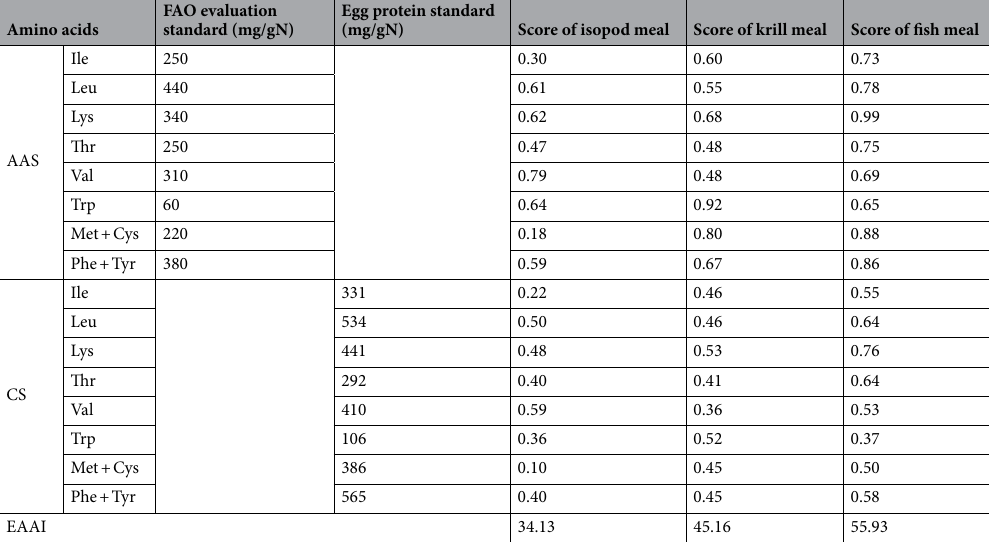
amino acid index) and essential amino acid index (EAAI) were calculated by converting the data in Table 2 into milligrams of amino acid per gram of nitrogen (× 62.5). The results were compared with the amino acid scoring standard pattern suggested by FAO/WHO and the standard amino acid pattern of whole egg protein. Amino Acid Score (AAS) and Chemical Score (CS) reflect the relationship of protein composition and uti- lization ratio from different perspectives. As can be seen from Table 3, in most of the case, the lowest scores are from the isopod meal, with Ile and Met + Cys in particular less than half of the value of krill meal and fishmeal. Isoleucine, Methionine and cystine are therefore the main limiting amino acids of isopod as suggested by their content. EAAI index reflects how close the essential amino acid content of material is to the standard protein (egg protein). Comparing the values of EAAI indicates that the protein quality of the isopod meal is worse than that of both krill meal and fishmeal. The high AAS and CS scores of fishmeal demonstrate that fishmeal is rich in essential amino acids and it is well-balanced in composition.